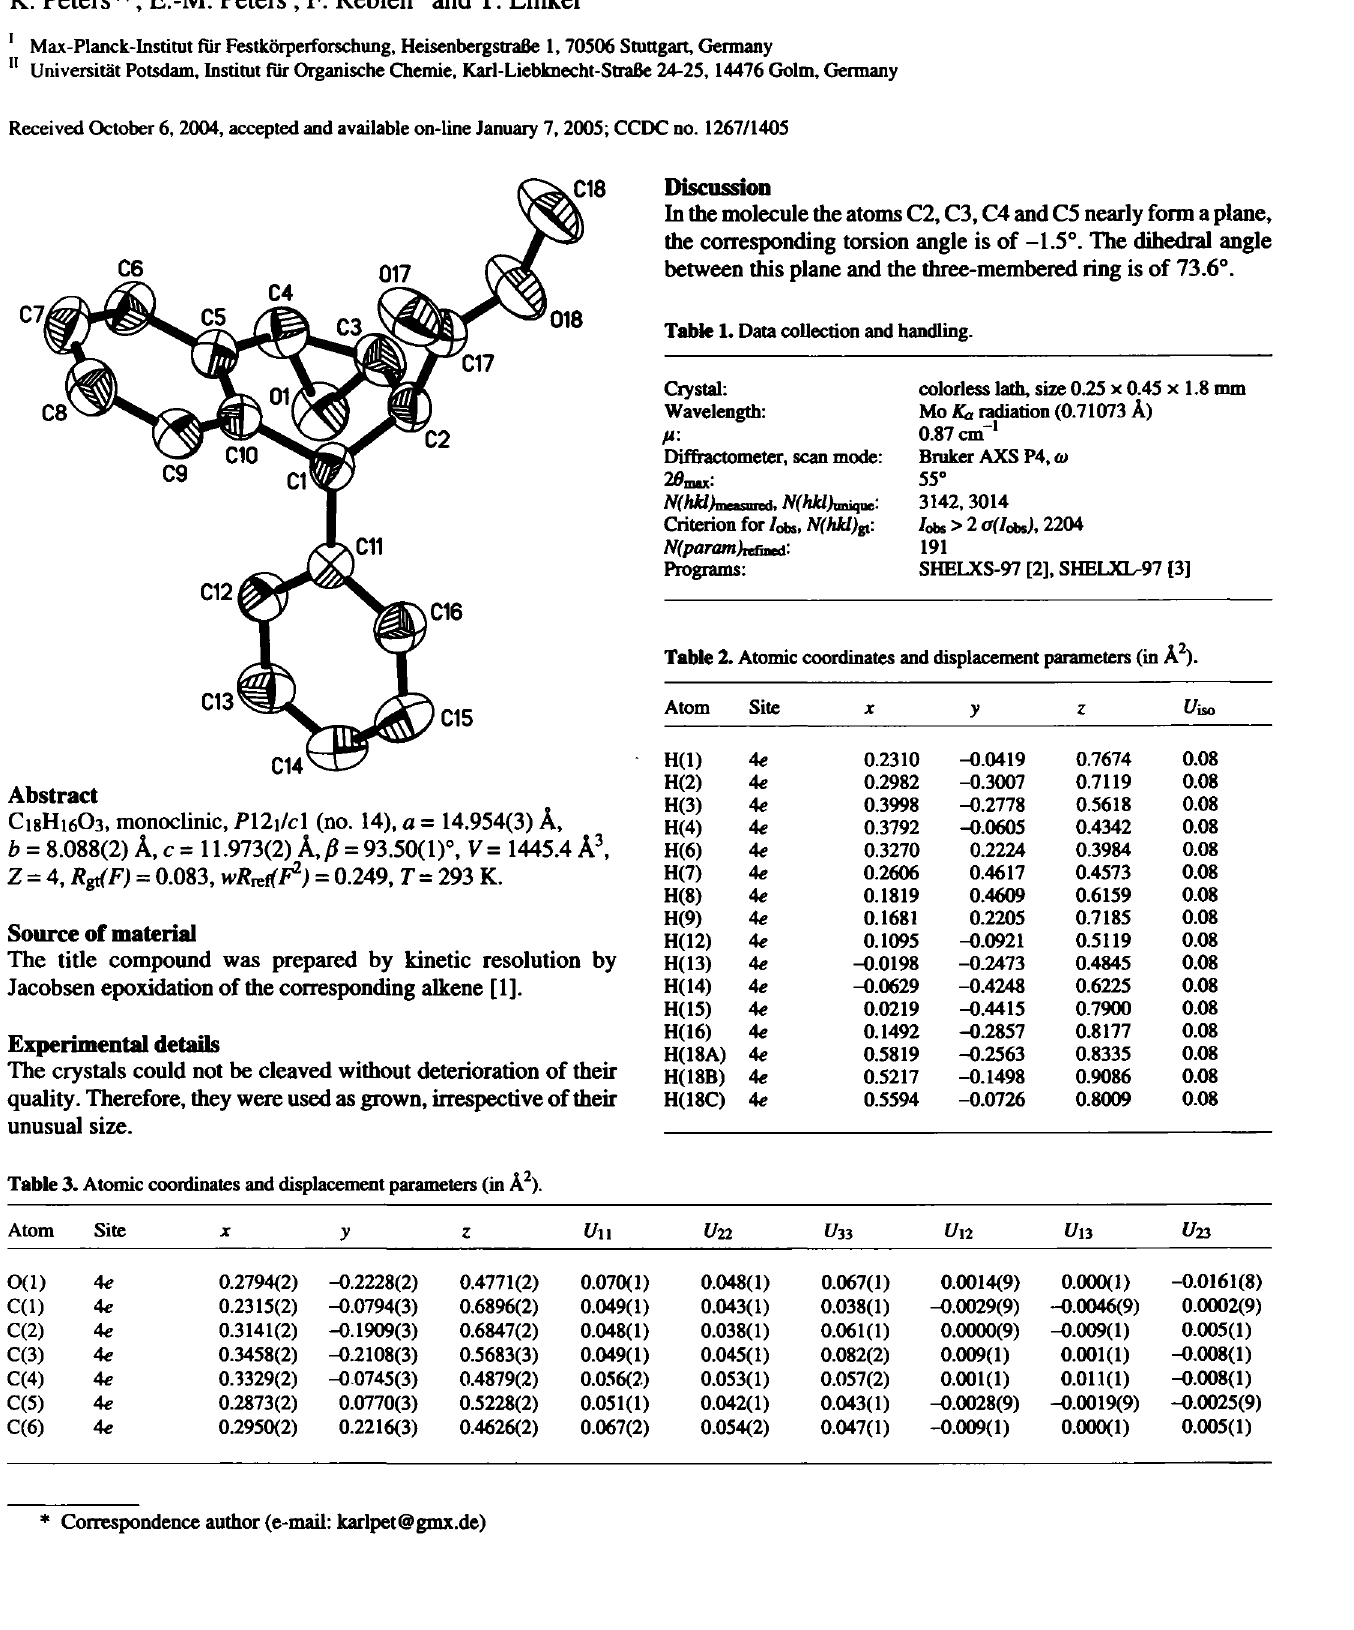
Table 1. Data collection and handling.